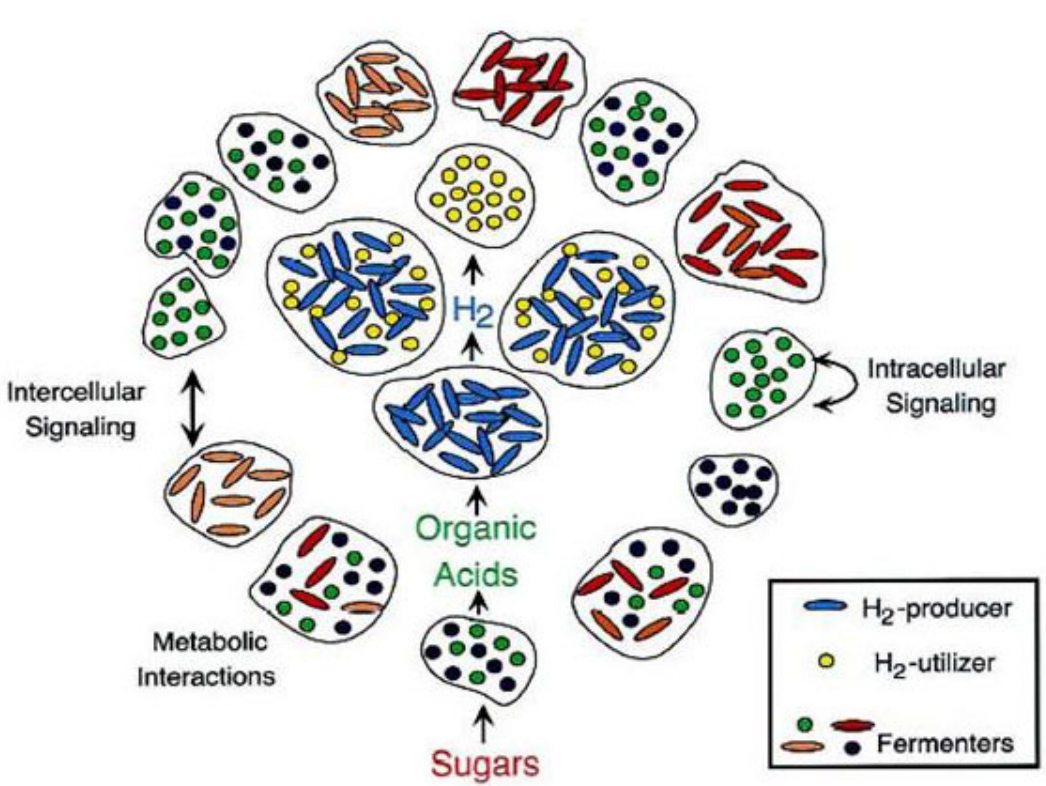
Figure 1. Example of microbial community ecology. The four central microcolonies correspond to organisms that generate and consume hydrogen. The fermenters use sugars and produce organic acids that are used by hydrogen producers. In addition to metabolic interactions, intra- and intercellular communication may be mediated by signaling molecules. Adapted from Davey and O’Toole